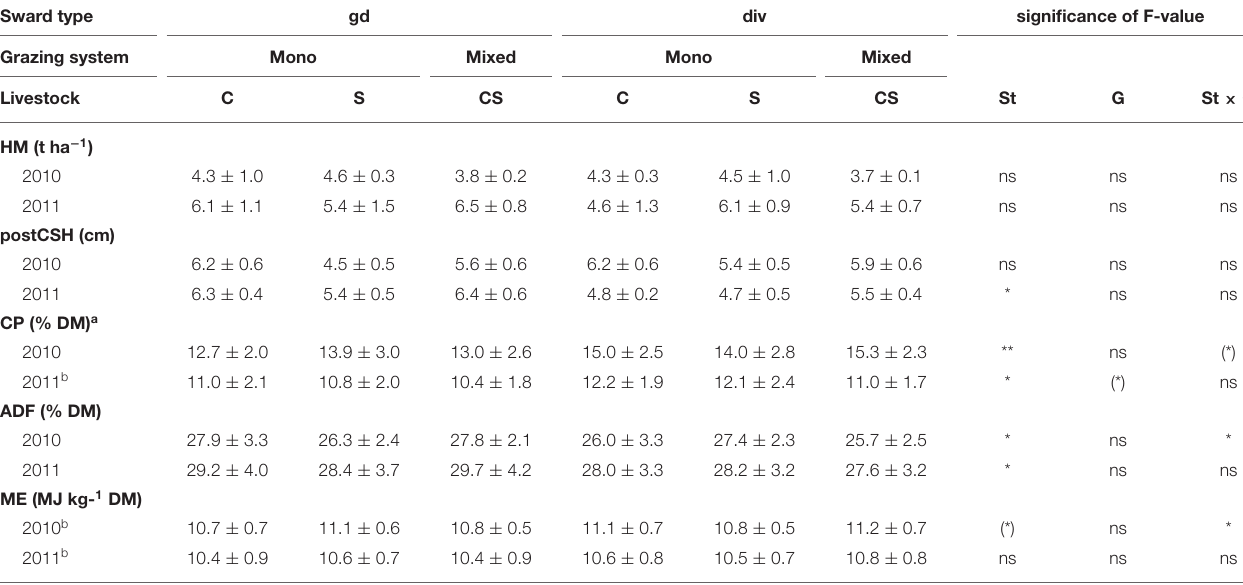
a Statistical results refer to log-transformed CP concentrations,. b The variance structure varident was used in the model to allow for different variances per grazing cycle.